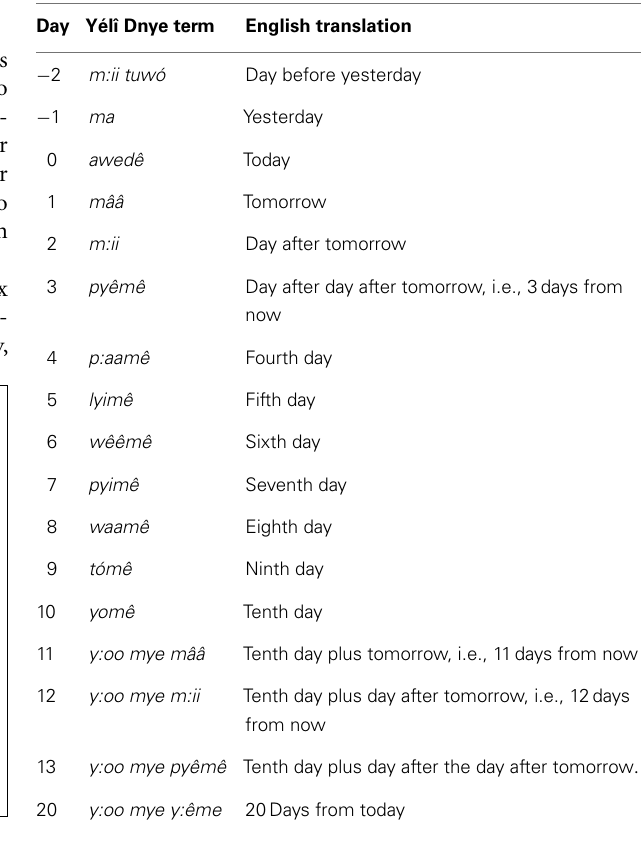
Table 1 | Special terms for days from 2 back to 20